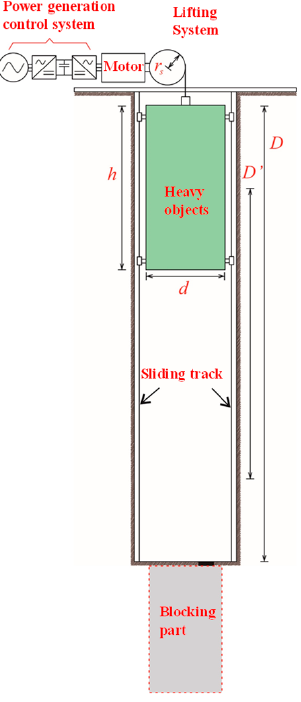
Figure 1. Schematic diagram of a gravity power generation station.